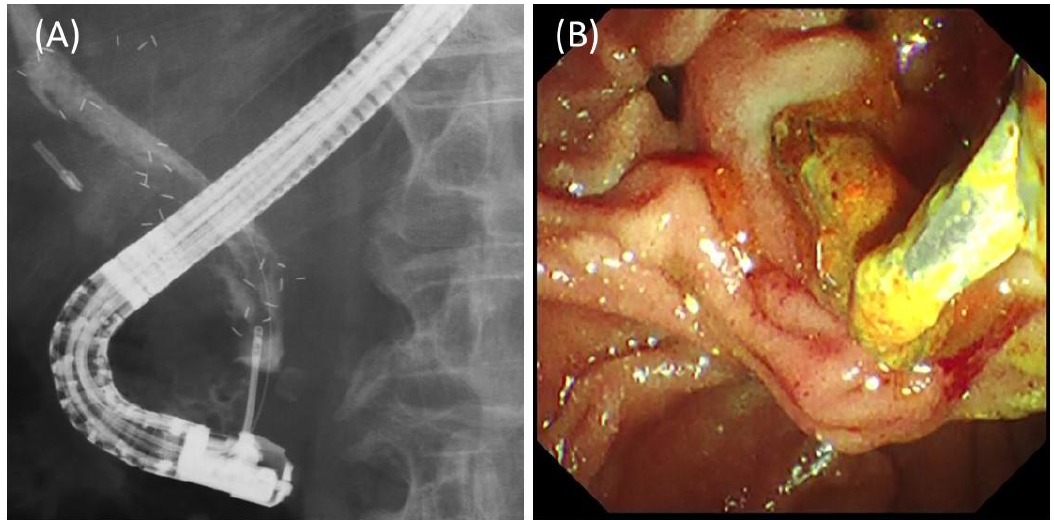
Figure 4. Revision for stent occlusion due to sludge in the case of three stent placements above